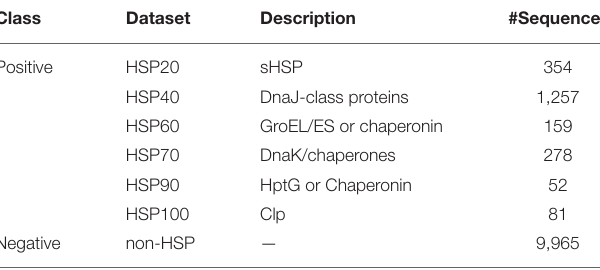
TABLE 1 | Summary of the positive and negative